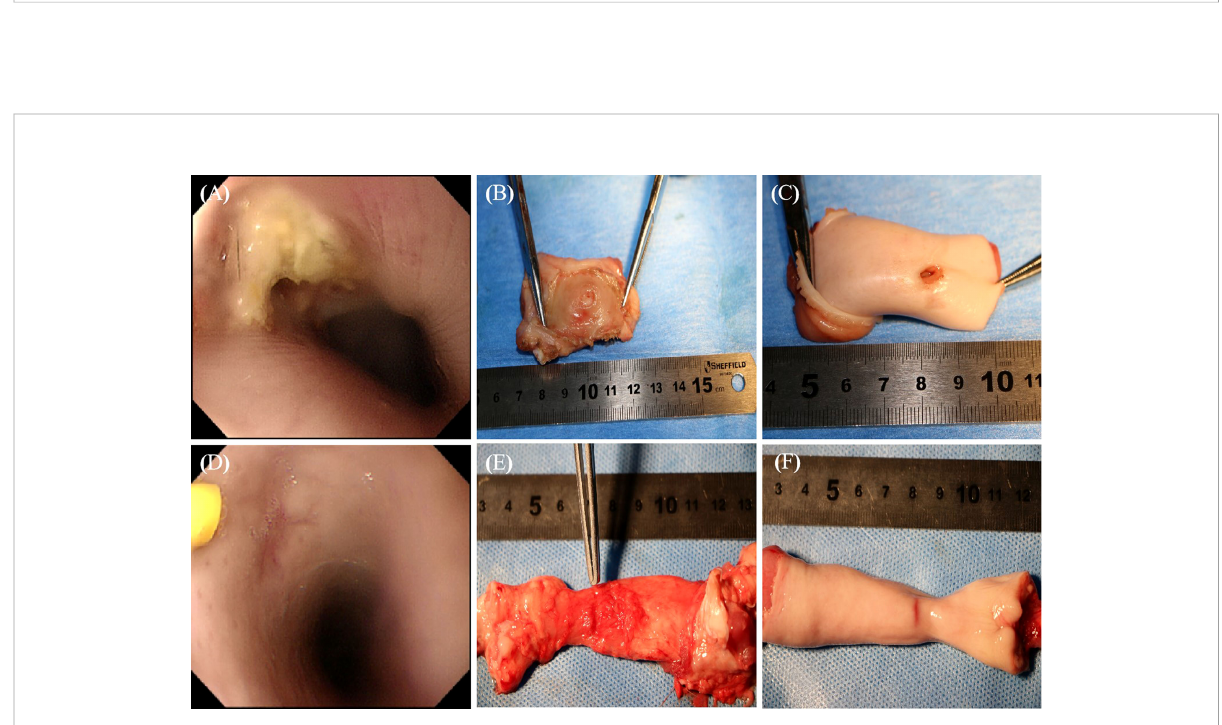
FIGURE 7 The representative images of specimens of esophagi at EALs with direct vision or gastroscope. (A) , The incomplete occlusion of EAL covered with a little purulent exudate observed using gastroscope. (B) , The outer layer of leakage (completely occluded) from the outer view. (C) , The inner layer of leakage (unhealed status) from inner views, which was mainly involved in the muscular layer. (A-C) , Representative images of specimens of esophagi at EALs in the control group. (D) , The complete occlusion of EAL covered with some cicatricial tissue detected using gastroscopy. The yellow syringe pointed to cicatricial tissue. (E, F) , The completely occluded leakage from both outer and inner views. (D-F) , Representative images of specimens of esophagi at EALs in the MSCs group. (B, E) , Outer view under direct vision. (C, F) , Inner view under direct vision. EAL, esophageal anastomotic leakage; MSCs, mesenchymal stromal